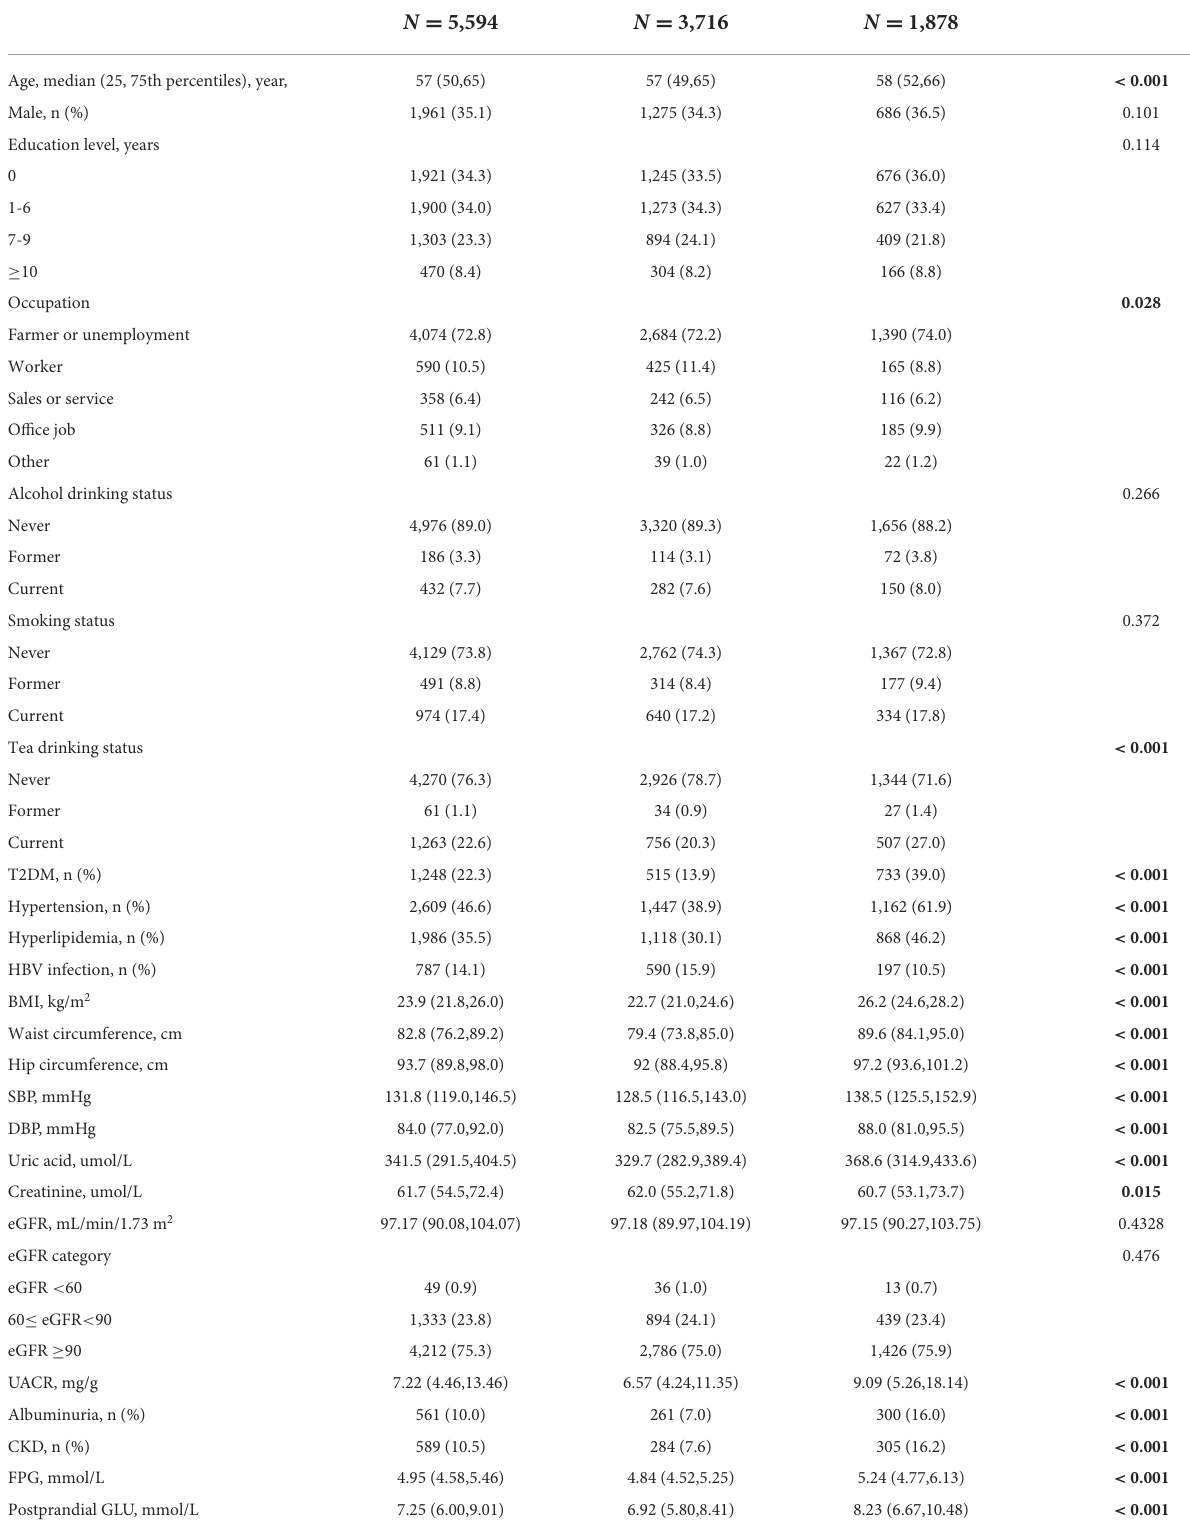
TABLE 1 General characteristics of subjects with and without